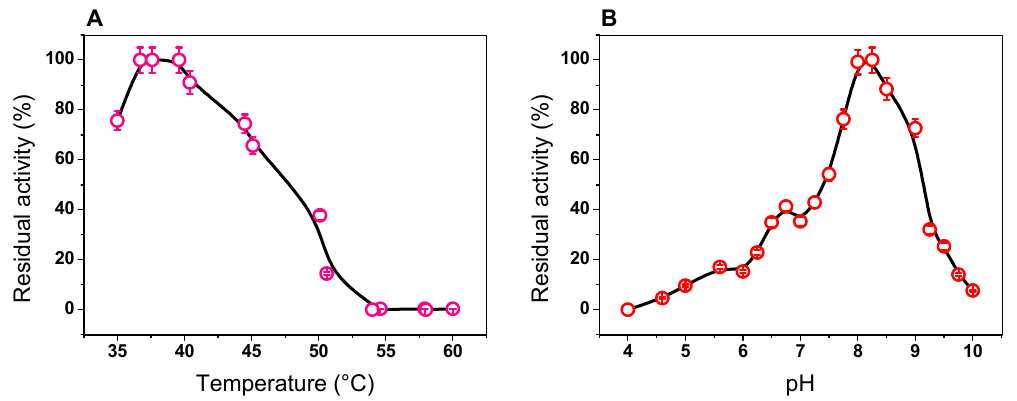
Figure 4. Effect of temperature and pH on the activity of the TvG6PD::6PGL protein. ( A ) The heat-inactivation profile of G6PD activity (pink circle). ( B ) Effect of pH on G6PD activity (red circle). The fused TvG6PD::6PGL protein was incubated at different temperatures (35–60 °C) for 20 min in 50 mM Tris buffer at pH 8.0. Error bars indicate the mean ± standard deviation of the triplicate values.